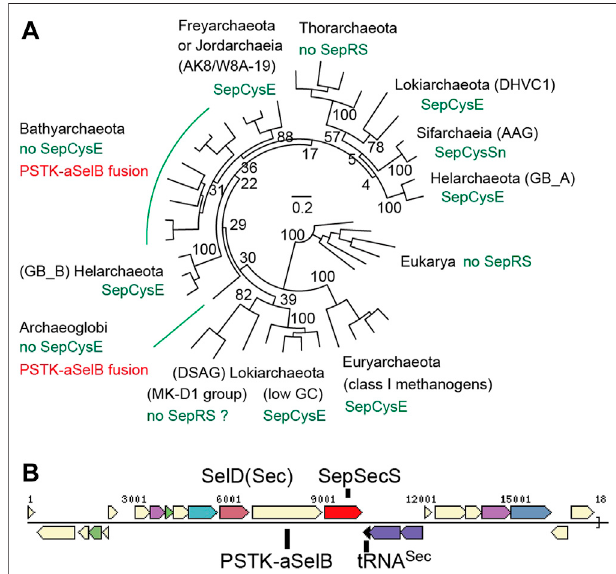
FIGURE 9 | Distribution and classi fi cation of Sec-encoding systems in archaea (A) ASepSecSphylogenetictreewithbootstrapvalues(percentages) made by maximum likelihood estimation with 100 replicates is shown (B) A typical gene cluster for Sec encoding and utilization in Bathyarchaeota